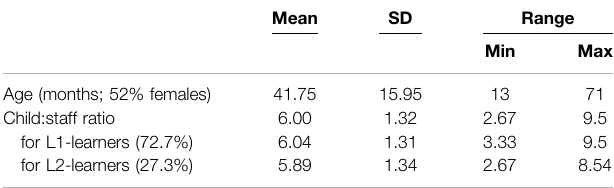
TABLE 1 | Demographic of preschool children and staf fi ng information.